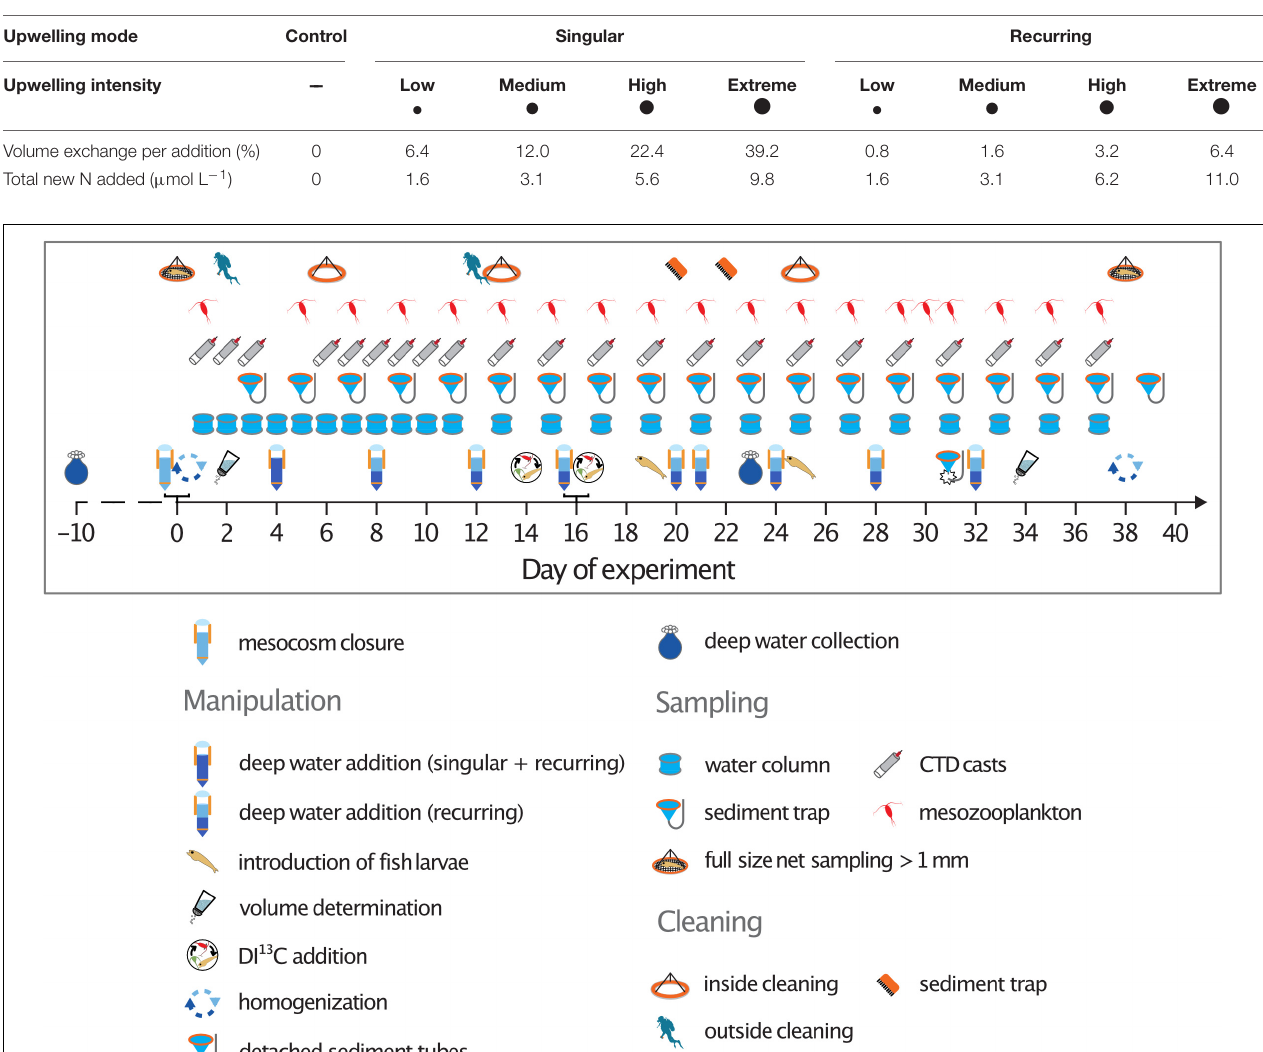
FIGURE 1 | Timeline of the experiment depicting the sampling schedule, cleaning activities, and